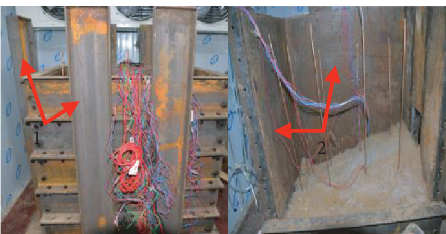
Figure 4: Simulation box and loading system. 1: reaction device; 2: loading plate.